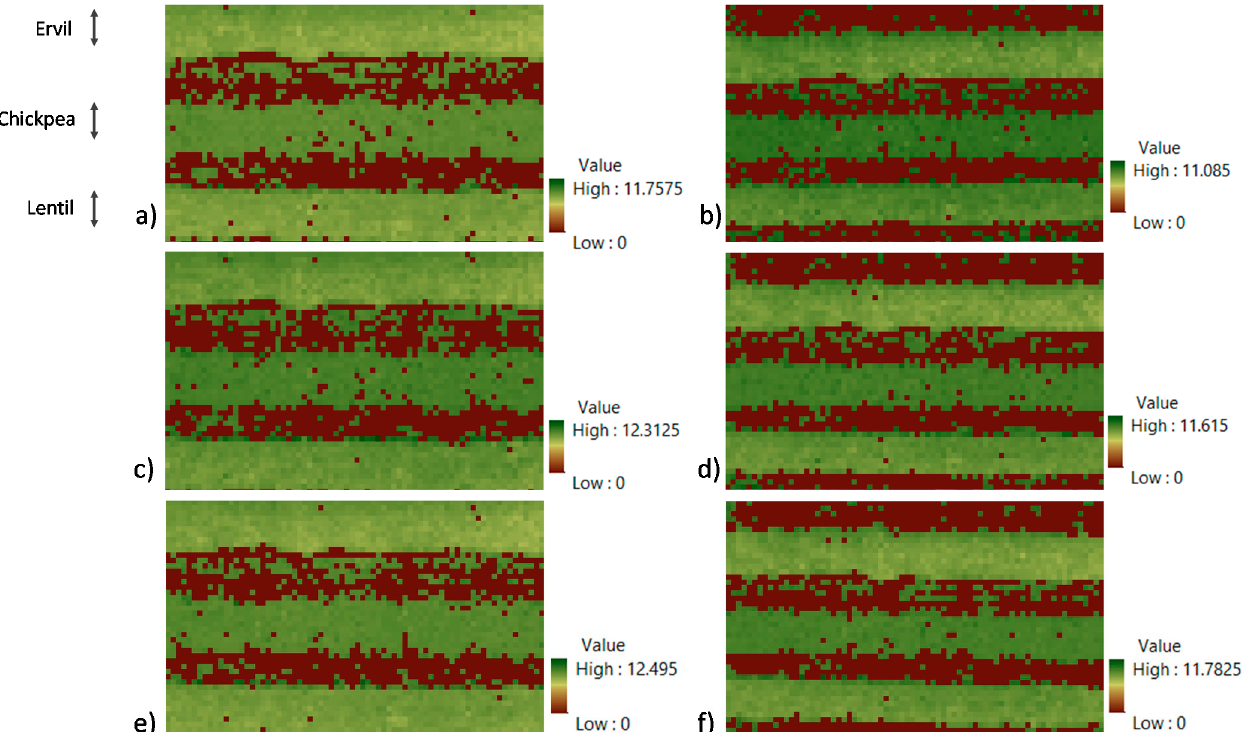
Figure 7. VSI AM before classification of the three gathered images and the two flying heights. ( a ) VSI AM 12 m image n° 1, ( b ) VSI AM 16 m image n° 1, ( c ) VSI AM 12 m image n° 2, ( d ) VSI AM 16 m image n° 2, ( e ) VSI AM 12 m image n° 3, ( f ) VSI AM 16 m image n° 3. The crops in the images from top to bottom lines are ervil, chickpea, and lentil.